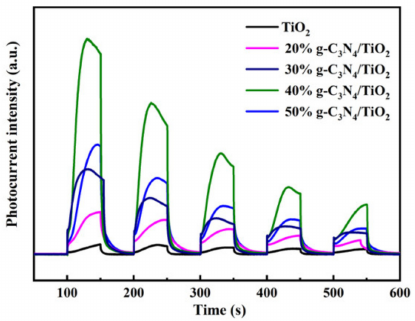
Figure 9. Photocurrent tests of TiO 2 and g-C 3 N 4 /TiO 2 samples with different mass